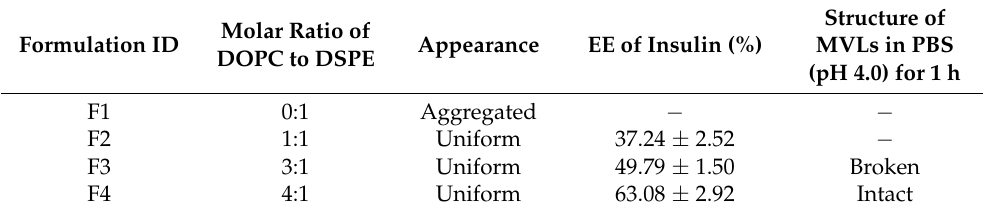
Table 1. Physicochemical properties of multivesicular liposomes with different molar ratios of DOPC to DSPE. Data are shown as mean ± SD ( n = 3).